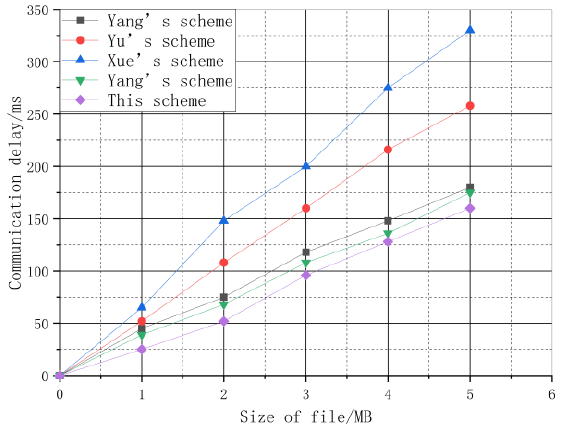
Figure 7. Experimental results of communication delay.